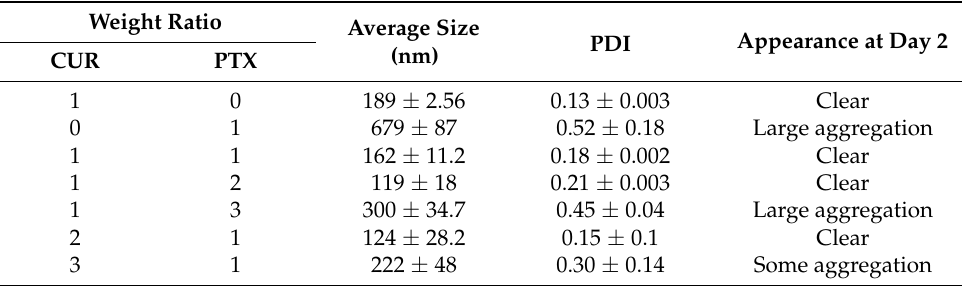
Table 1. The effects of different weight ratios of PTX and CUR on the preparation of NPs. PTX and CUR stand for paclitaxel and